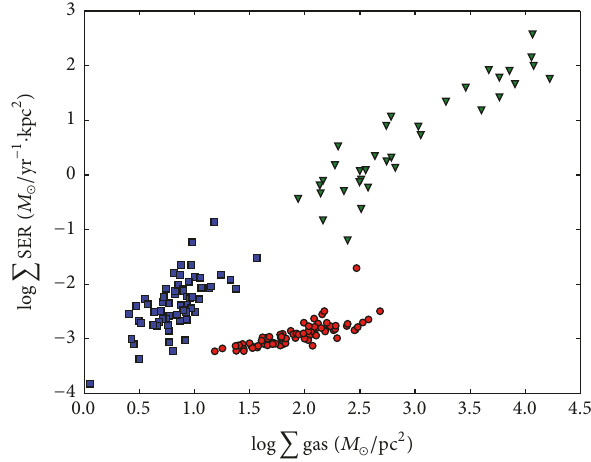
Figure 4: Relation between the surface density of molecular gas ∑ H ∑ SFR for normal galaxies (blue squares), starburst 2 and galaxies (green triangle), and the elliptical galaxy Centaurus A (red circles). The gas surface density is derived from CO(2-1) emission. The normal and starburst galaxy samples are obtained from Kennicutt [13].